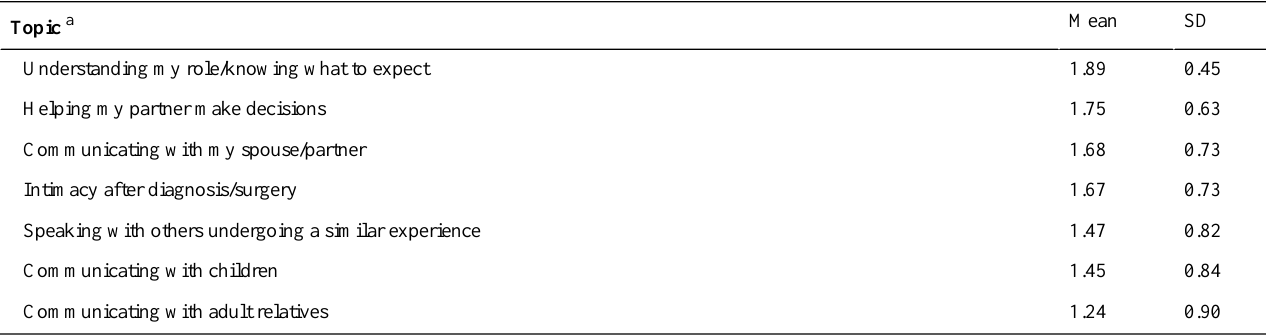
Table 2. Preferred psychoeducational content